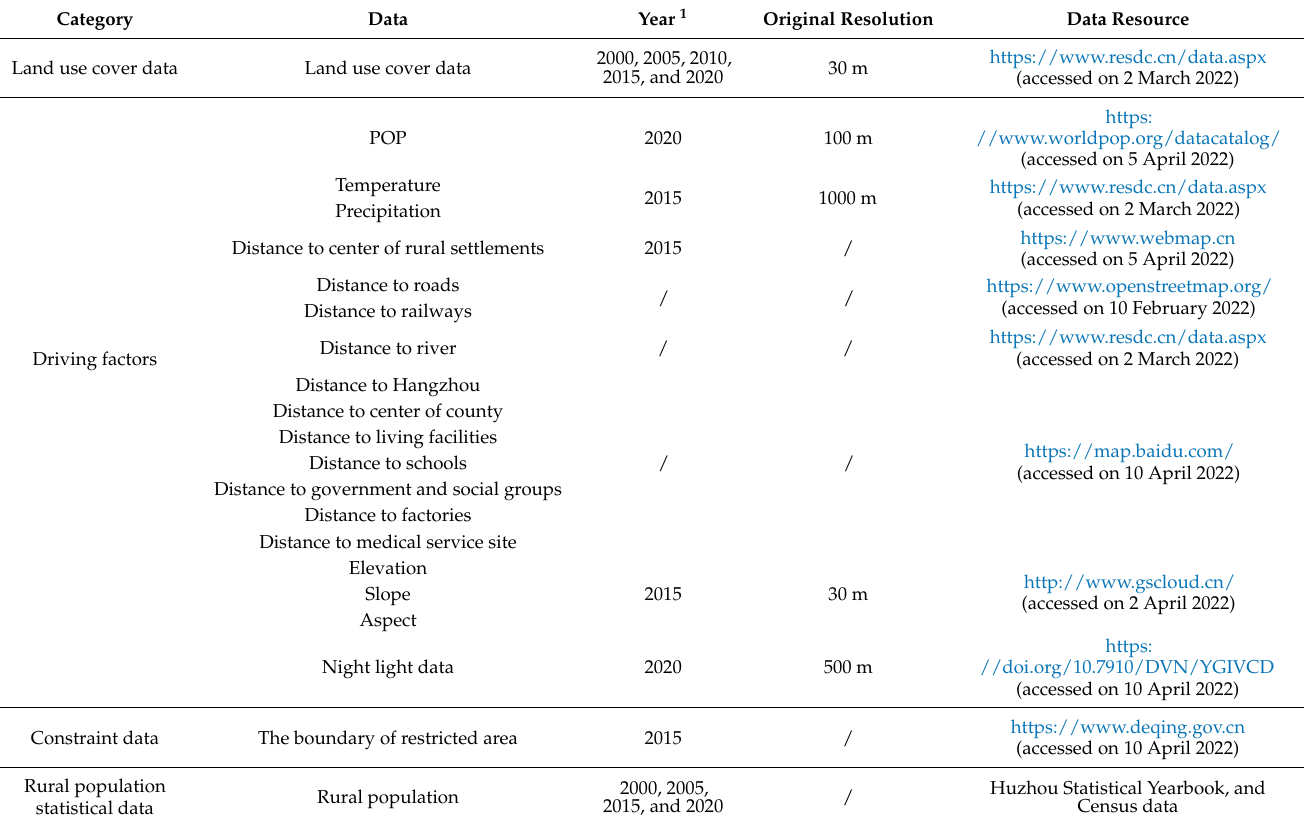
Table 1. Research datasets used in this study.